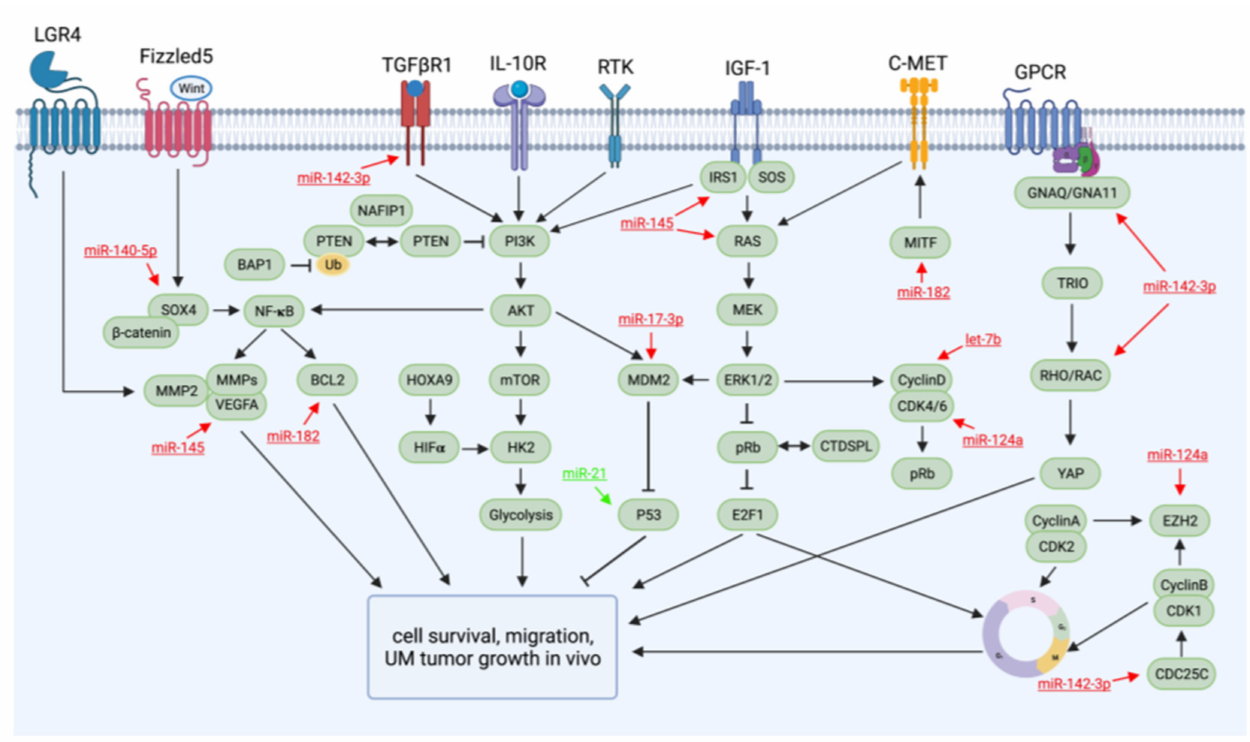
Figure 1. Major aberrant signaling pathways in UM and targets of miRNAs with therapeutic